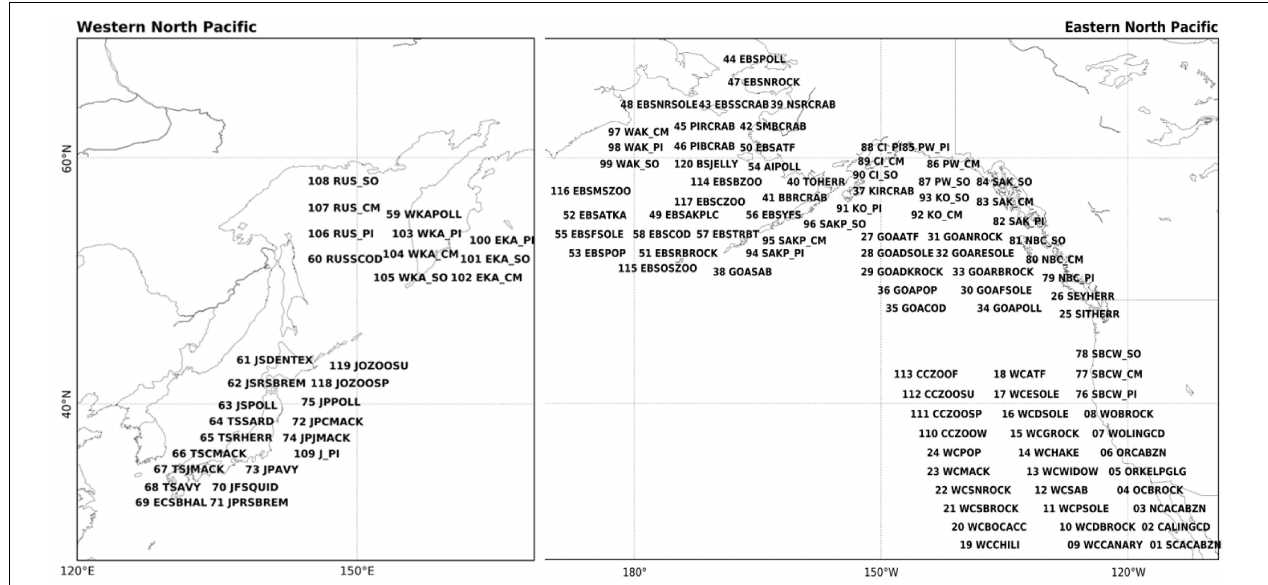
FIGURE 1 | Identification number and alphabetic abbreviations for the 120 marine species data. See Supplementary Table 1 for a definition of each abbreviation. The locations of the species on the map are approximate.